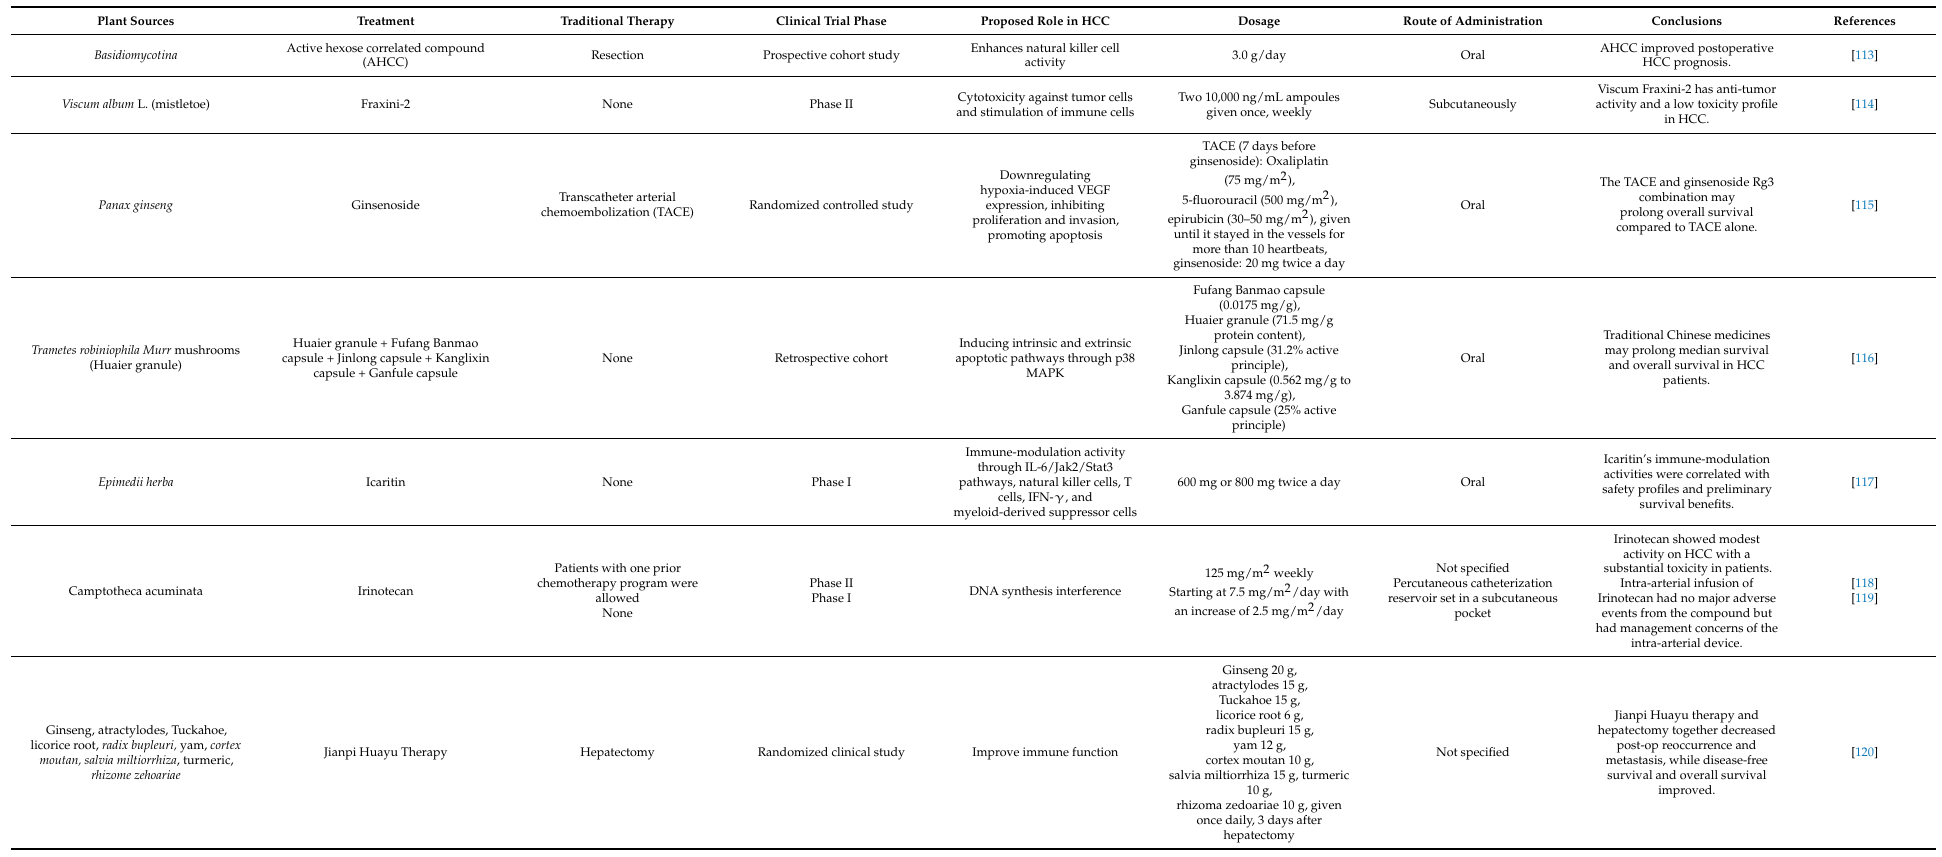
Table 2. Phytochemicals used in clinical trials for HCC